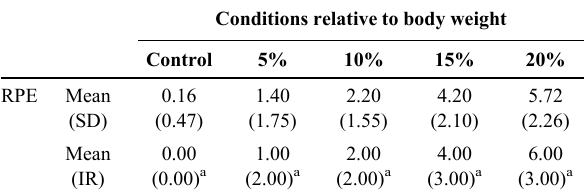
Table 3 - Comparison of the RPE values in the different conditions rela- ted to body